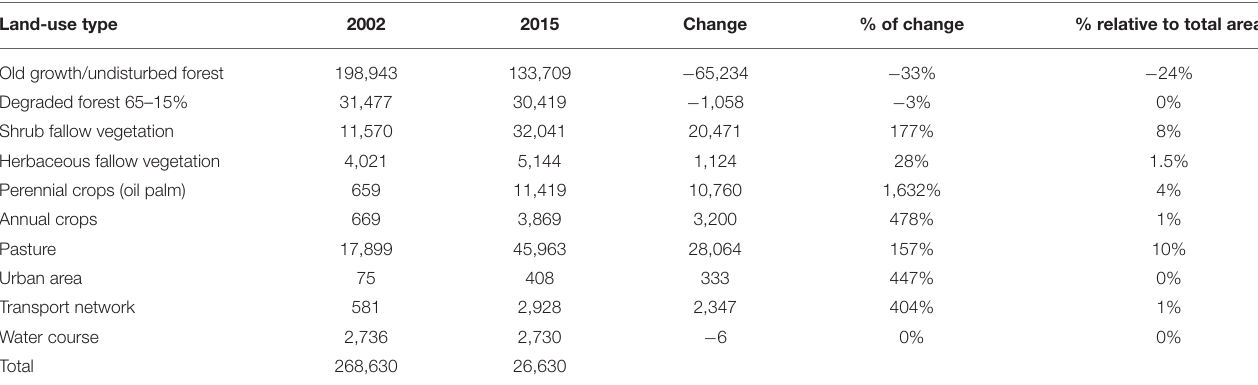
TABLE 6 | Land-use change (ha) between 2002 and 2015 in the district of Irazola, Ucayali, Peru. Land-use